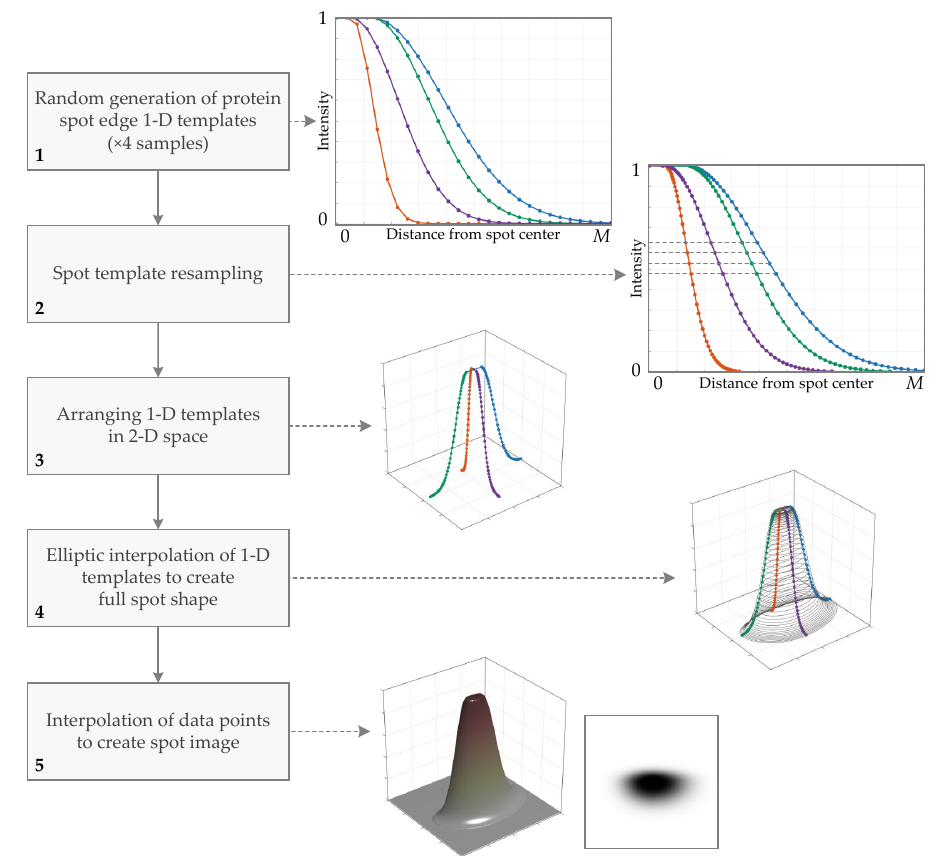
Figure 4. Overview of the generation process of the protein spot prototype (primary spot). Outcomes of the workflow steps (image samples) are presented on the side and linked by the dashed lines. The color of line indicates the same 1D protein spot edge template in the